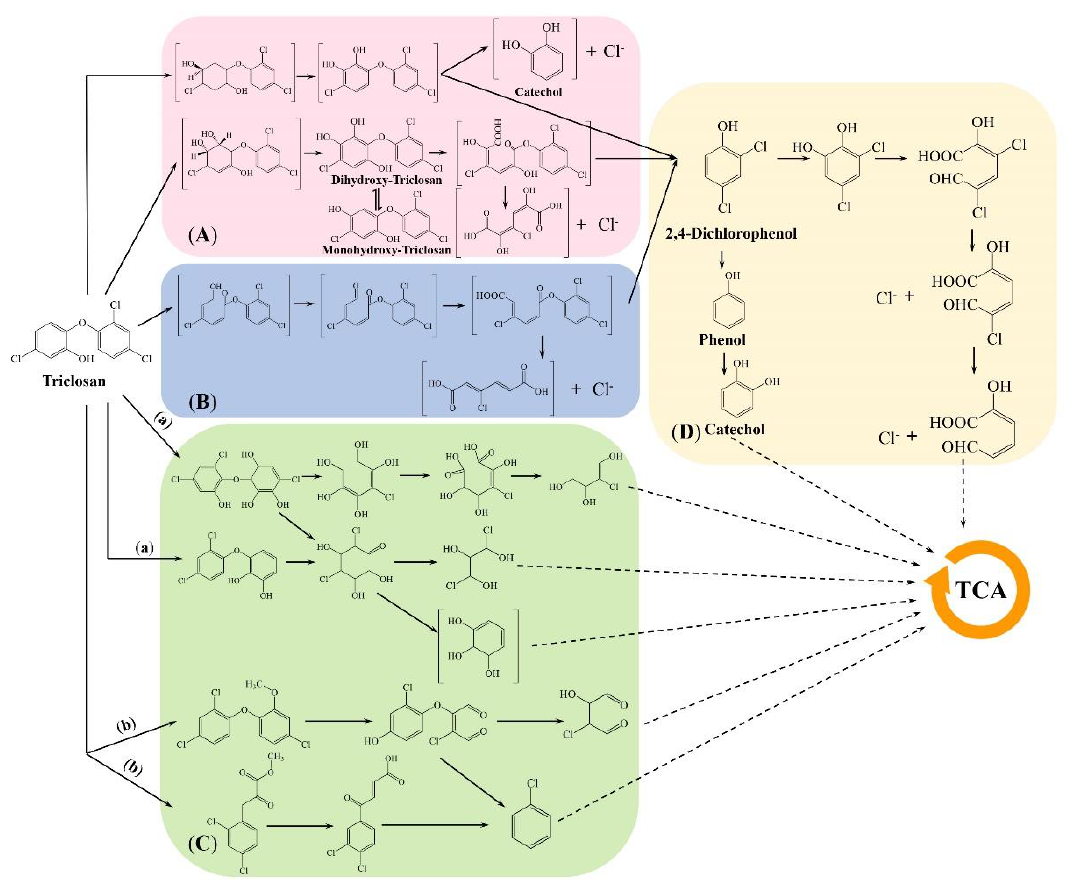
Figure 3. Proposed degradation pathway of TCS by microorganisms. ( A ). Meta -cleavage pathways [76,81,83]; ( B ). Ortho -cleavage pathways [74]; ( C ). Others: (a). Proposed degradation pathway of TCS by Dyella sp. WW1 [79]; (b). Proposed degradation pathway of TCS by Providencia rettgeri MB-IIT [18]. ( D ). Common downstream pathway of meta -cleavage and ortho -cleavage pathways.